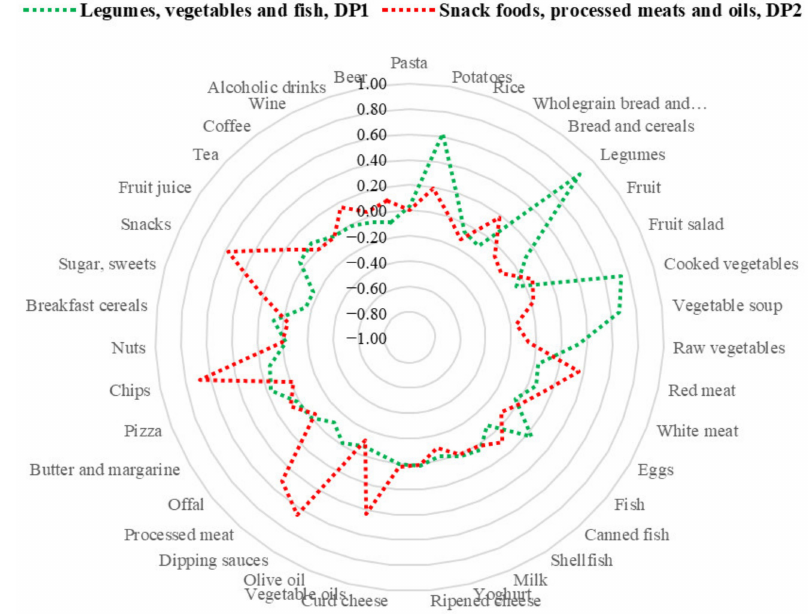
Figure 1. Radar plot of factor loadings of the main dietary patterns identified in Italian women.